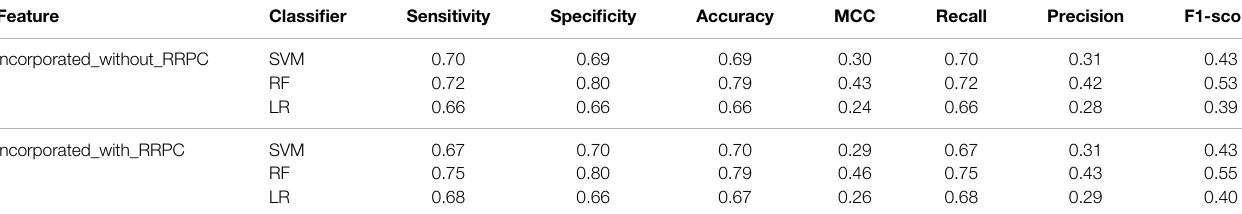
TABLE 1| Performanceofincorporatedfeatures inthecaseswithorwithoutRRPC incorporated.Here,thesequence-based features usedforincorporationcontainBinary, CKSAAP (k (cid:2) 1, 2, 3), EAAC, EGAAC, and PSSM.